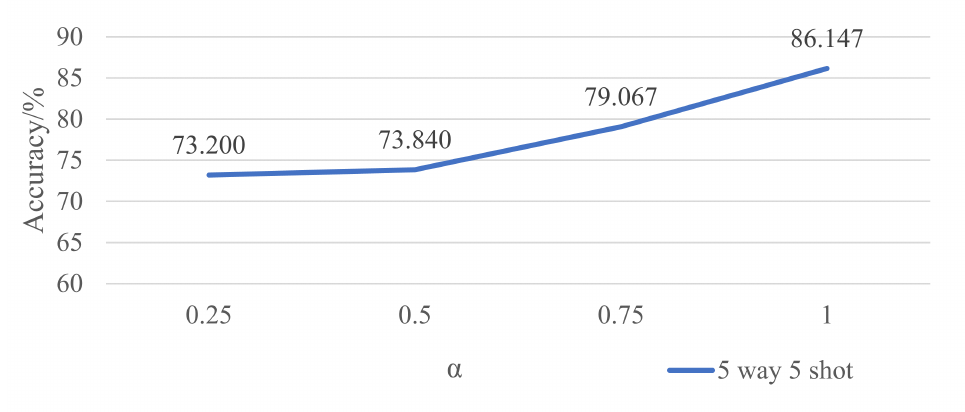
Figure 9. Experiments on extra loss from clustering of support set against α in a five-way five- shot setting.